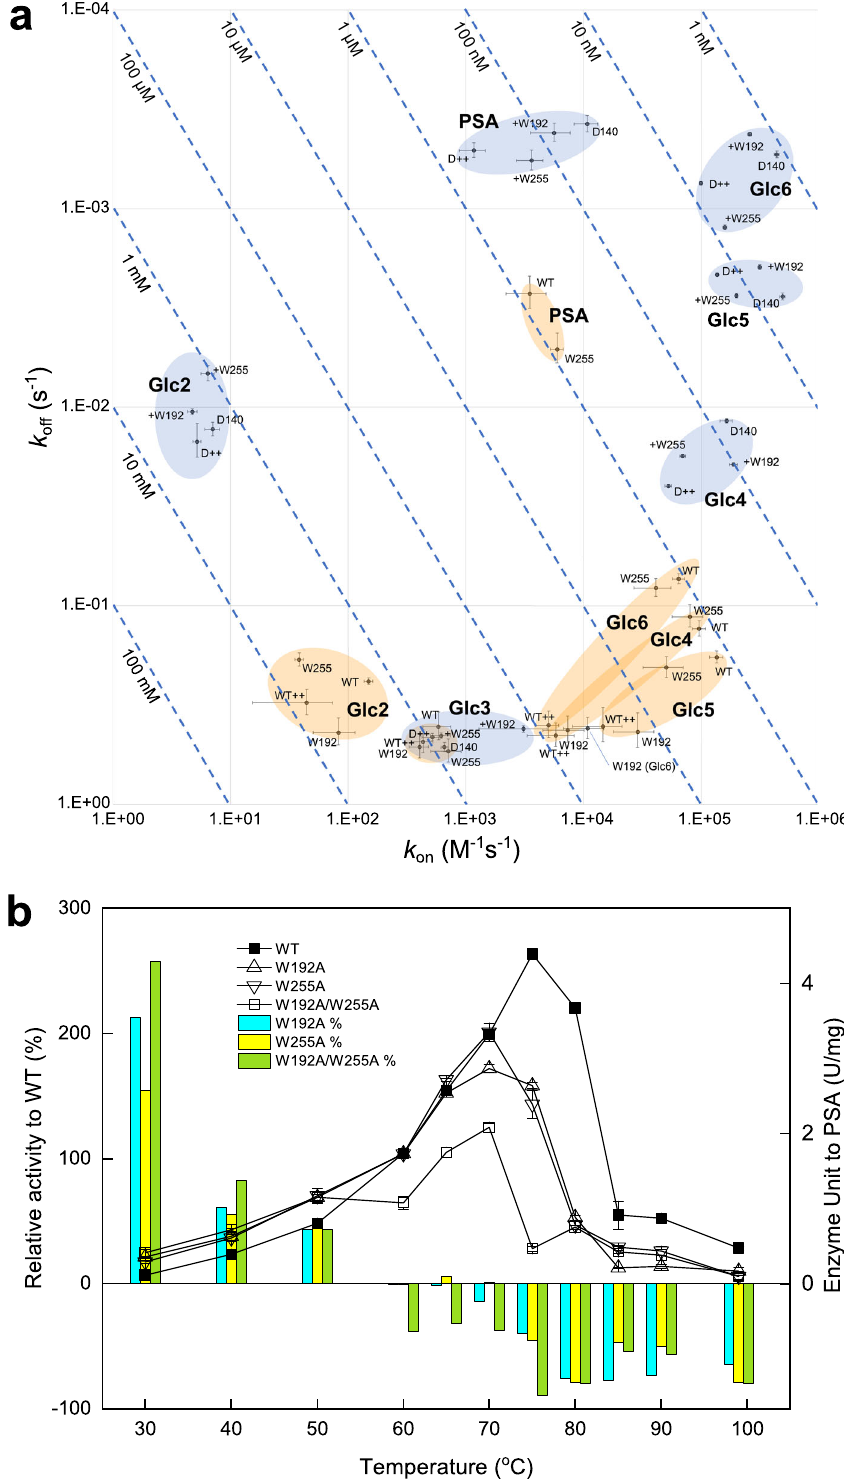
Fig. 5 Effects of W192 and W255 mutation in HmCel6A. a SPR k on - k off plot for various degrees of polymerisation in substrates. Cyan and orange ellipsoids correspond to being with and without catalytically de fi cient mutations (D140A), respectively. Each error bar represents the standard error. b Enzyme activity against temperature. Relative activity against the wild-type enzyme and enzyme unit are drawn in bar and line, respectively. Each of the two tryptophans affect turnover at lower temperatures and enzyme stability at higher